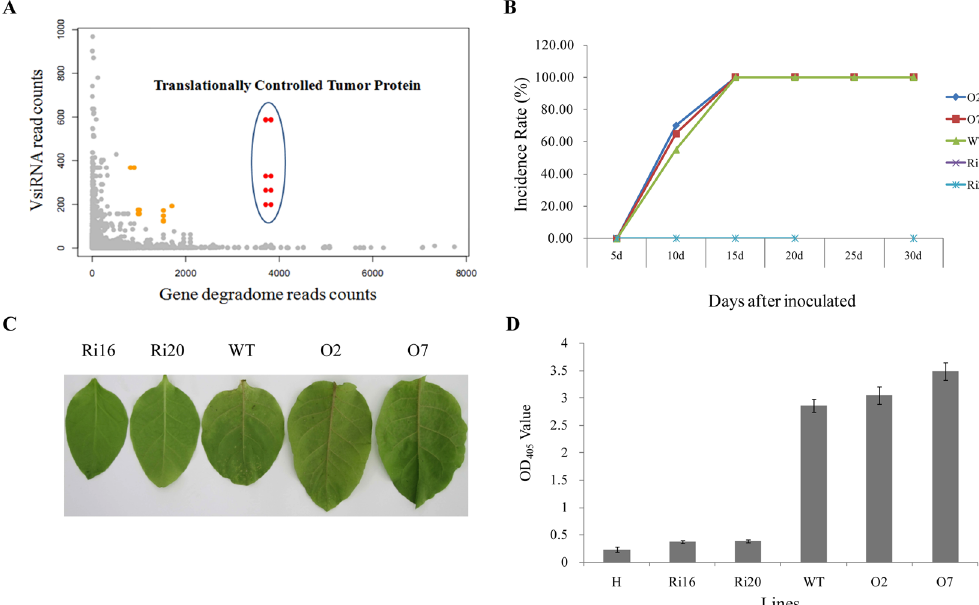
Figure 6. Virus-derived siRNA (vsiRNA) from PVY targets NtTCTP mRNA and mideates plant resistance to PVY infection.( A ) VsiRNA from PVY targets NtTCTP mRNA, x-axis represents the read counts of degradome sequencing for the genes that predicted as the targets of vsiRNA from PVY genome, y-axis represents vsiRNA reads from PVY genome;( B ) The incidence rate of NtTCTP overexpressing lines O2, O7,wild type and NtTCTP silencing lines Ri16, Ri20; ( C ) Typical symptoms of NtTCTP overexpressing lines O2, O7,wild type and NtTCTP silencing lines Ri16, Ri20.( D ) Virus concentration of healthy plant ( H ), NtTCTP overexpressing lines O2, O7,wild type and NtTCTP silencing lines Ri16, Ri20 detected by